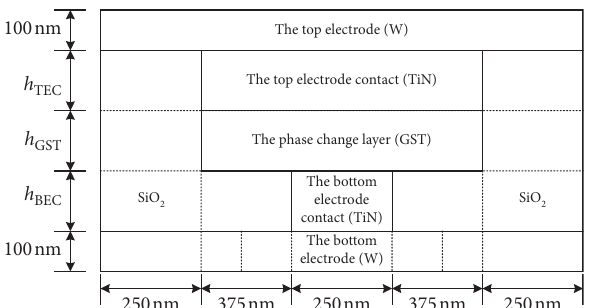
Figure 2: Cross-sectional structure of a typical resistance change